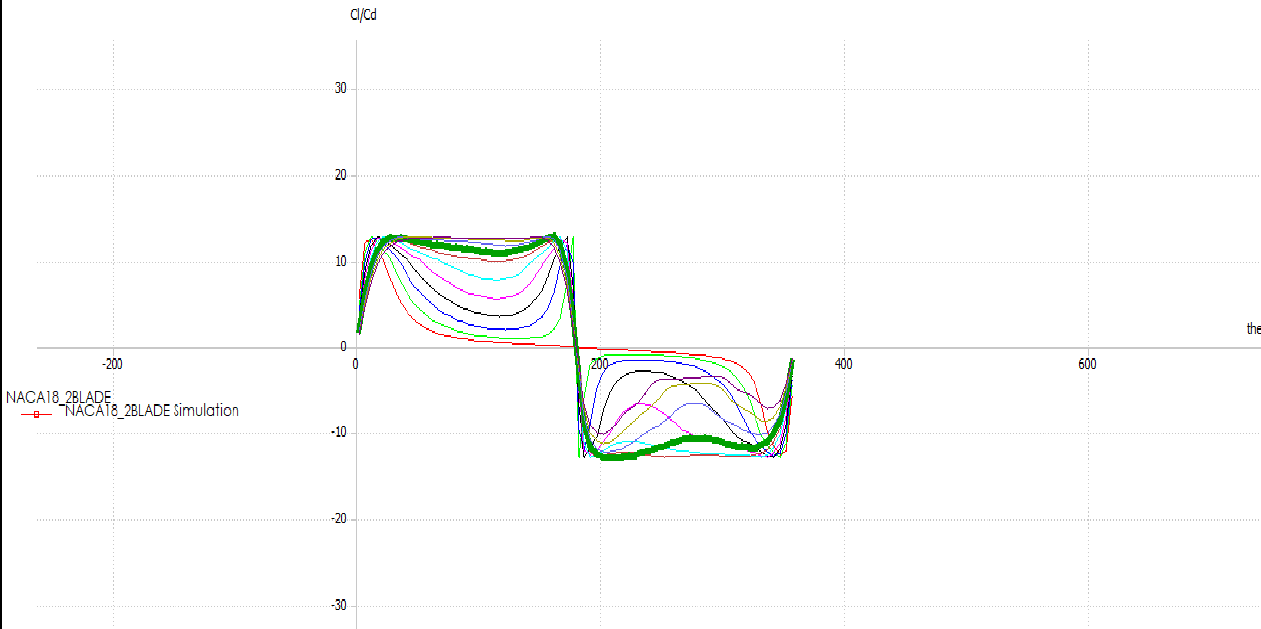
Figure 15. Cl/Cd vs theta plot of mid-section for TSR